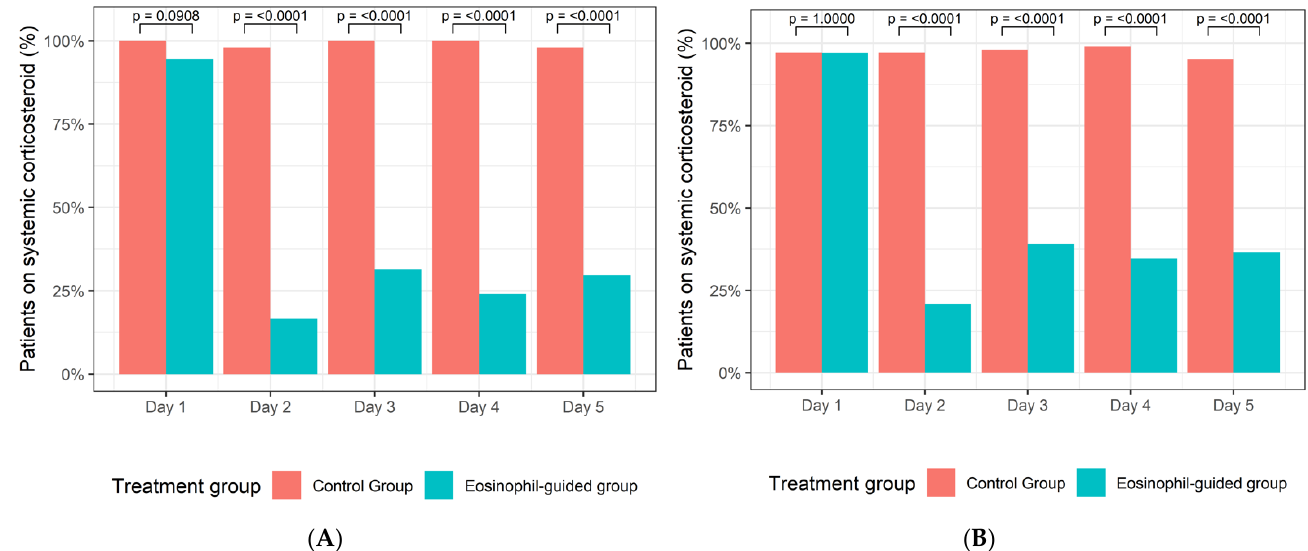
Figure 2. ( A ) Percentage of smokers in the control group and the eosinophil-guided group receiving systemic corticoster- oids from days 1–5. ( B ) Percentage of ex-smokers in the control group and the eosinophil-guided group receiving systemic corticosteroids from days 1–5.